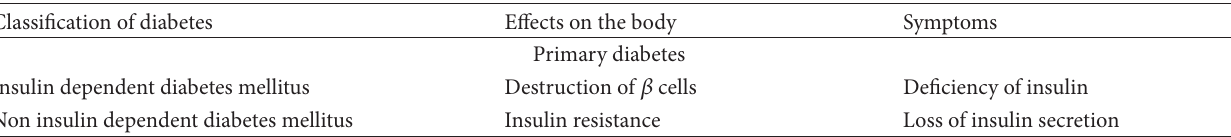
Table 1: Representation of the multiple primary and secondary forms of diabetes, the defective metabolism, and the adverse effects on the body